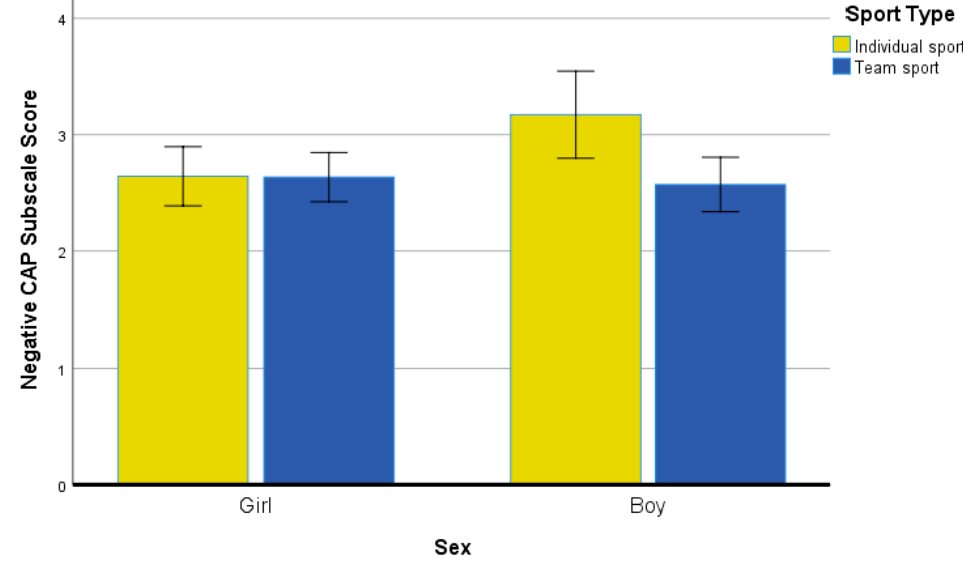
Figure 1. Negative CAP Subscale Scores for Sex and Sport Type Groups.